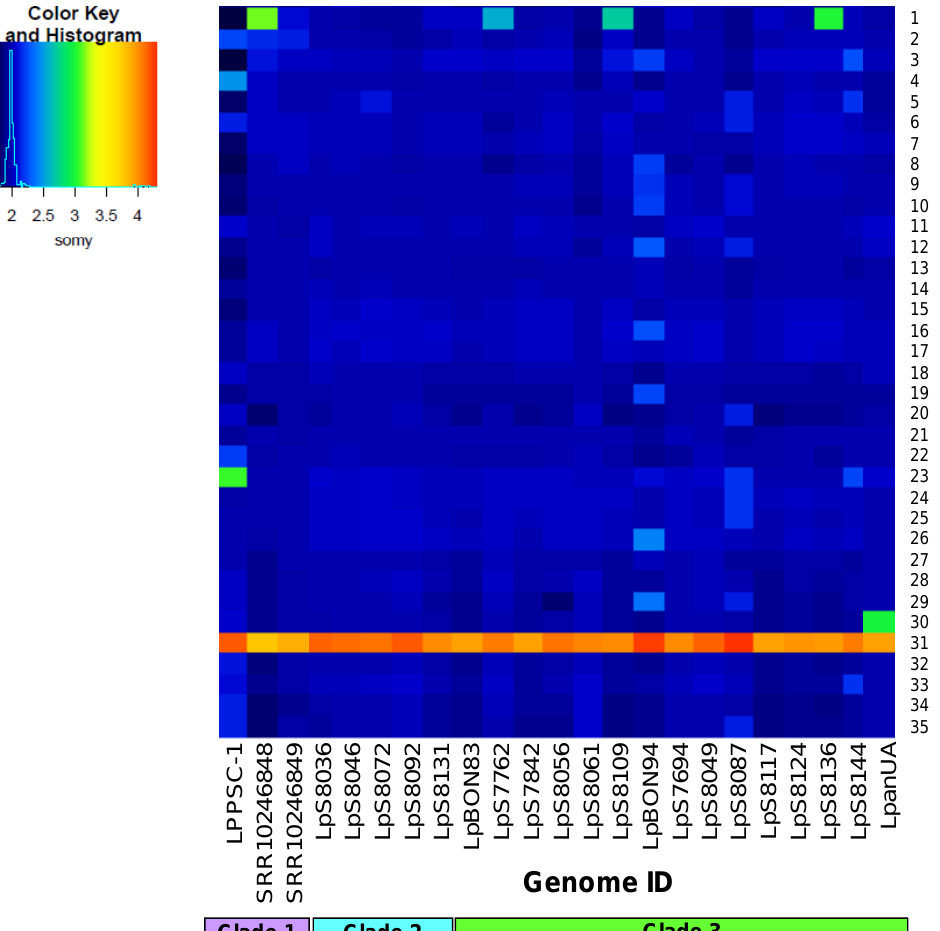
Figure 2. Dynamics of somy among the genomes of Leishmania panamensis analyzed. The heatmaps show median normalized read depths of 35 chromosomes ( y -axis) identified in each genome of L. panamensis ( x -axis) The color key indicates the somy value (S), which ranged from 1 to 5 as follows: monosomy, S < 1.5; disomy, 1.5 ≤ S < 2.5; trisomy, 2.5 ≤ S < 3.5; tetrasomy, 3.5 ≤ S < 4.5; and pentasomy, 4.5 ≤ S < 5.